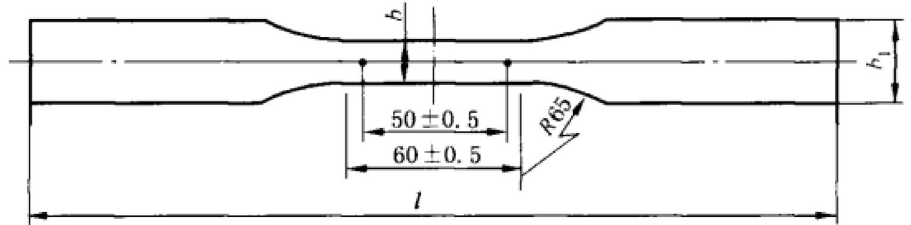
Figure 3. The tension properties test specimen.